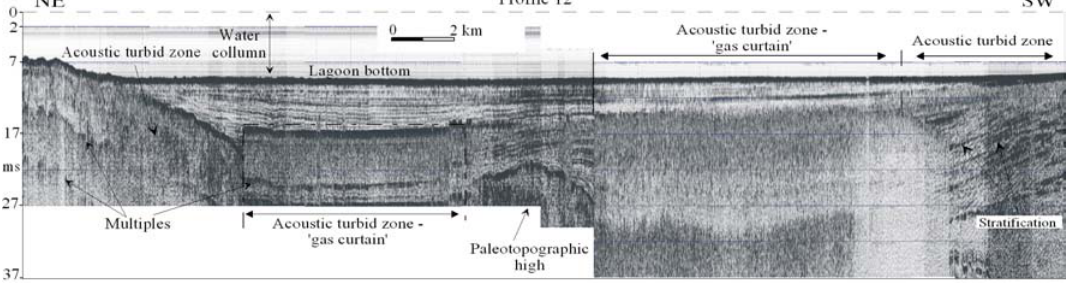
Fig. 3 – Linkage of gas occurrences to areas of paleotopographic lows in profile 12 (see Fig. 1 for location). Depths to water surface in two-way traveltime, in milliseconds